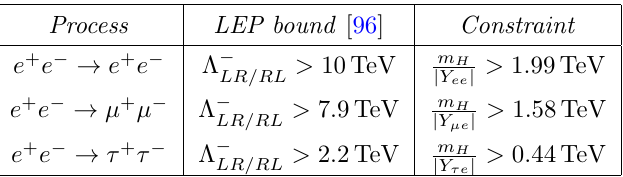
Table 8 . Constraints on the ratio of heavy neutral scalar mass and the Yukawa couplings from LEP contact interaction